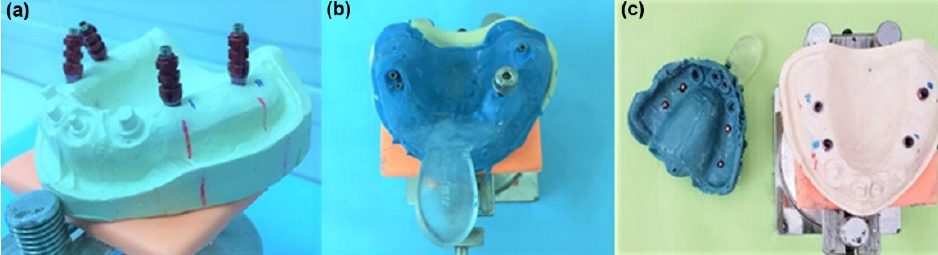
Figure 5. Direct (open) impression method: ( a ) twisted transfers, ( b ) addition silicone impression in the screw unfastening phase, and ( c ) polyether impression.